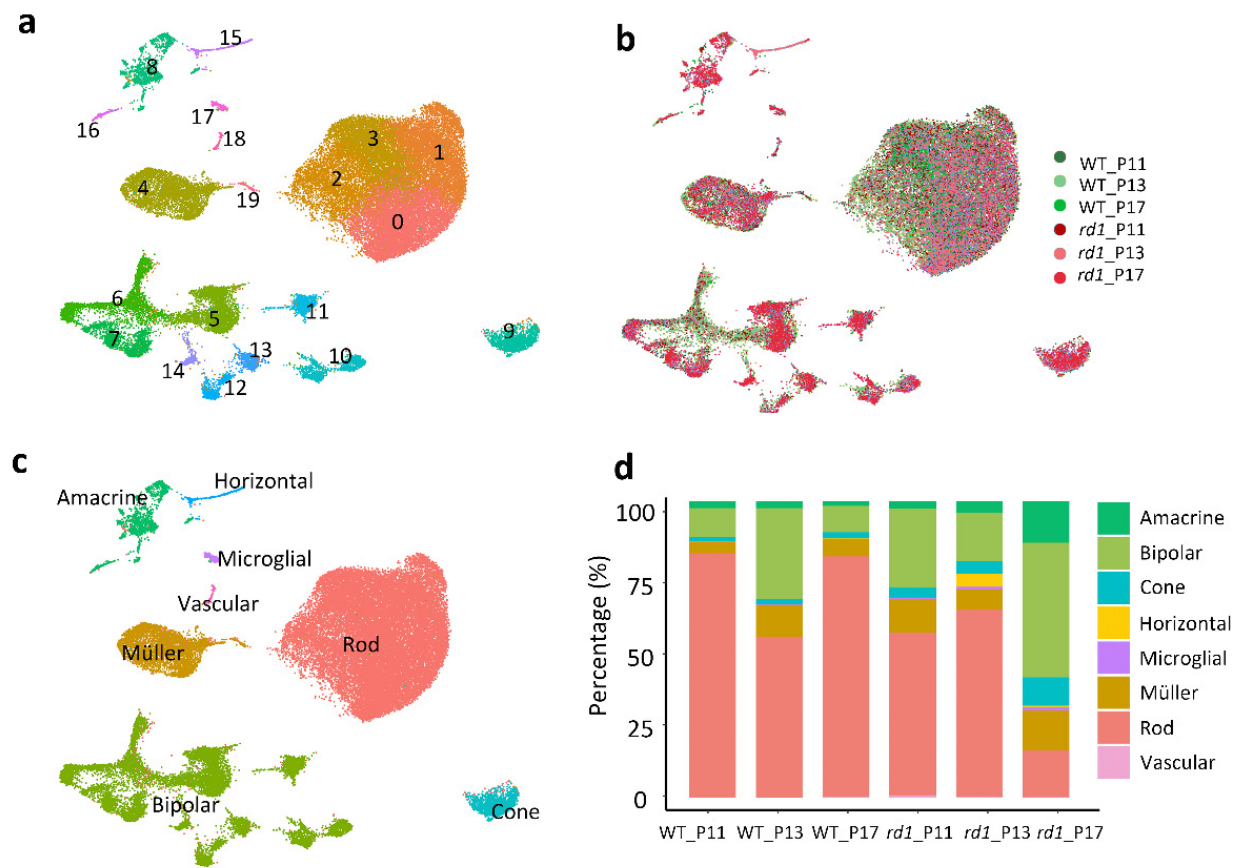
Figure 2. Single-cell RNAseq analysis of WT vs. rd1 mouse retinas. ( a ) A total of 43,979 cells isolated from wild-type (WT) and retinal degeneration-1 ( rd1 ) retinas were grouped into 20 identified clusters. ( b ) Distribution of all isolated cells clustered temporally. ( c ) All isolated cells color-coded by retinal cell type. ( d ) Bar graphs displaying the percentages of cell types identified in WT and rd1 samples at P11, P13, and P17. Note the marked decrease of rod photoreceptors in the rd1 P17 samples.